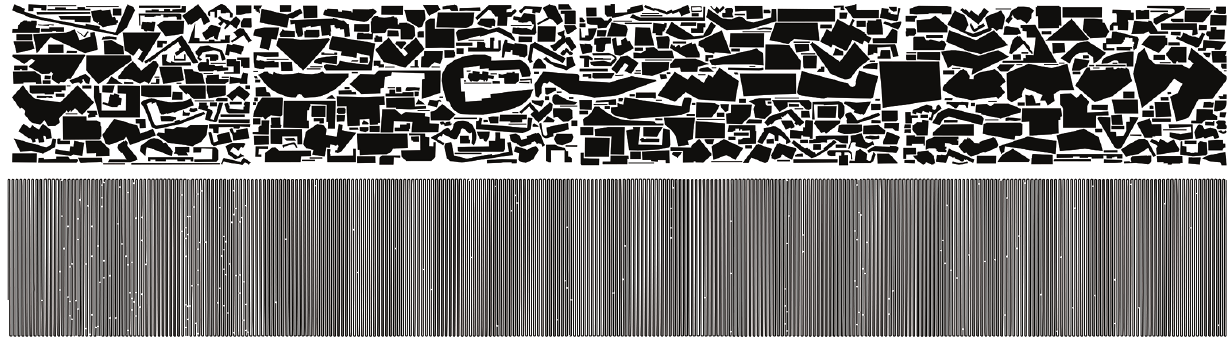
Figure 1. Top: All OSM car parking spaces of Johannesburg packed into a rectangle using the polygon packing library SVGNest. Bottom: The matching area of a segment of coiled up OSM streets of Johannesburg. The figure is rotated by 90